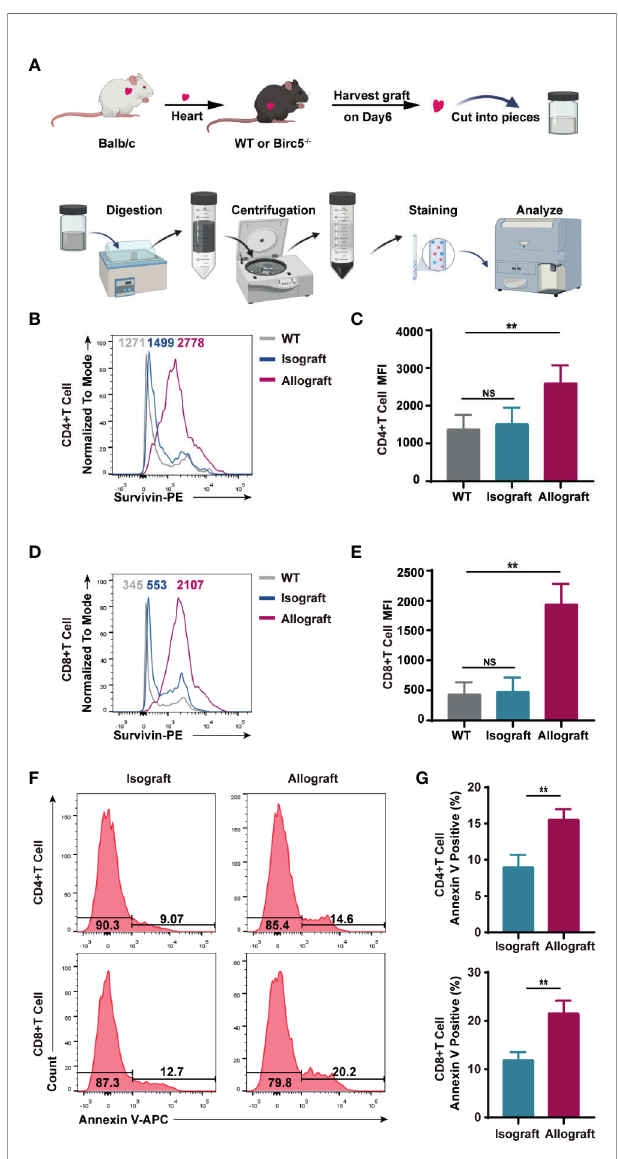
FIGURE 1 | T cells in murine heart allografts had high expression of survivin and apoptosis compared to those in the isograft group. (A) A schematic of the experimental design and procedure of isolating heart in fi ltrating lymphocytes. (B – D) Representative histogram plots of survivin. (C, E) Bar graphs of the MFI (mean fl uorescence intensity) of CD4 + and CD8 + T cells. T cells were isolated from the isograft or allograft mice, 6 days after transplantation. (F) A representative histogram of Annexin V staining of CD4 + and CD8 + T cells derived from in fi ltrated CD45+ cells in isograft and allograft mice. (G) FCM analysis of the percentage of Annexin V positive CD4 + and CD8 + T cells in isograft and allograft mice. Data are representative of 3 independent experiments (n = 4-6 mice per group). Bars represent the mean ± SD. ** p < 0.01, ns, not statistically signi fi